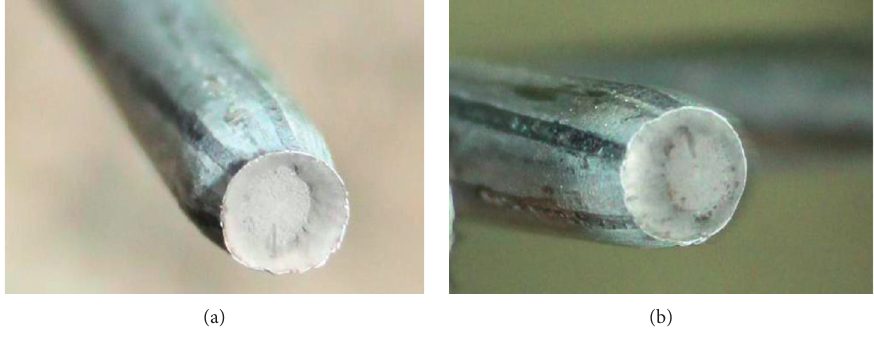
Figure 6: Fracture of uncorroded steel strand wire.